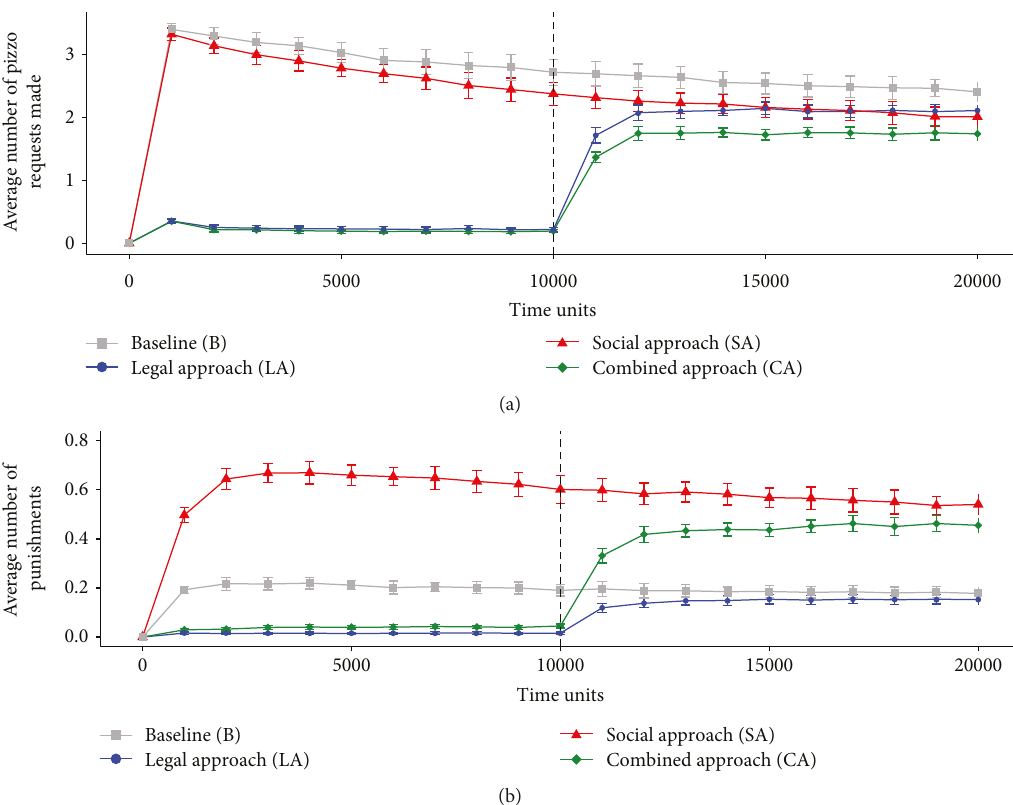
Figure 4: Actions of the ma fi a. Means plotted and error bars indicate ± 1 standard deviation. The number of (a) pizzo requests made by ma fi osi and (b) punishments in fl icted upon entrepreneurs. The dashed line indicates the change to baseline